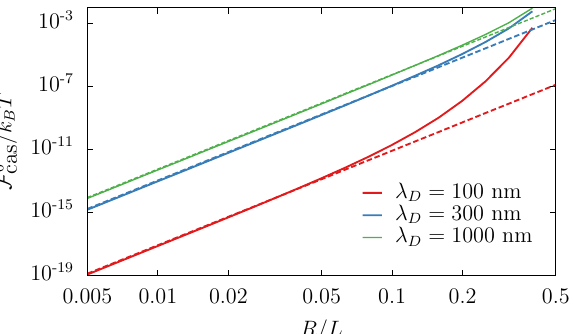
Figure 3. Zero-frequency contribution to the Casimir energy for two silica spheres of radius R as a function of R / L for a fixed L = 1 µ m and different Debye lengths: numerical (solid) and small-sphere approximation (46)